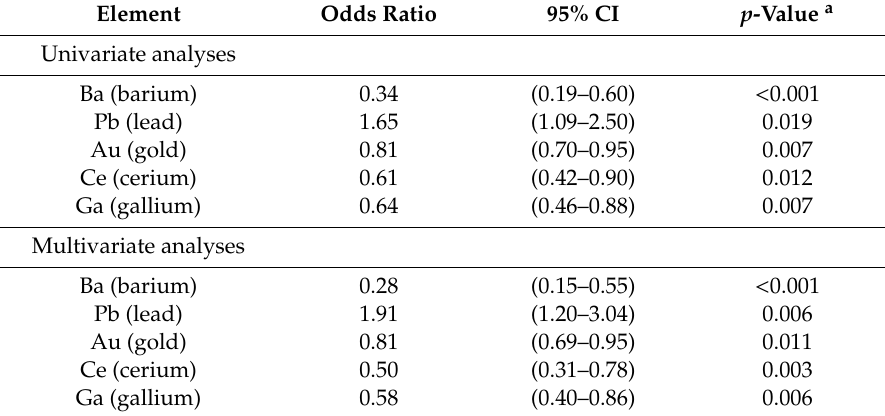
Table 3. Inorganic elements significantly associated with